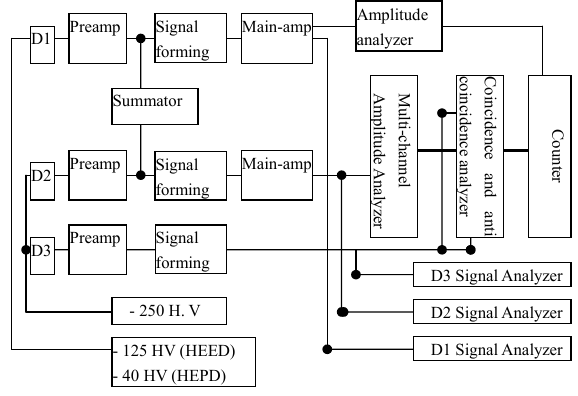
Fig. 3. Block diagrams of HEED and HEPD. three SSDs make it possible to separate electrons, protons, and heavy